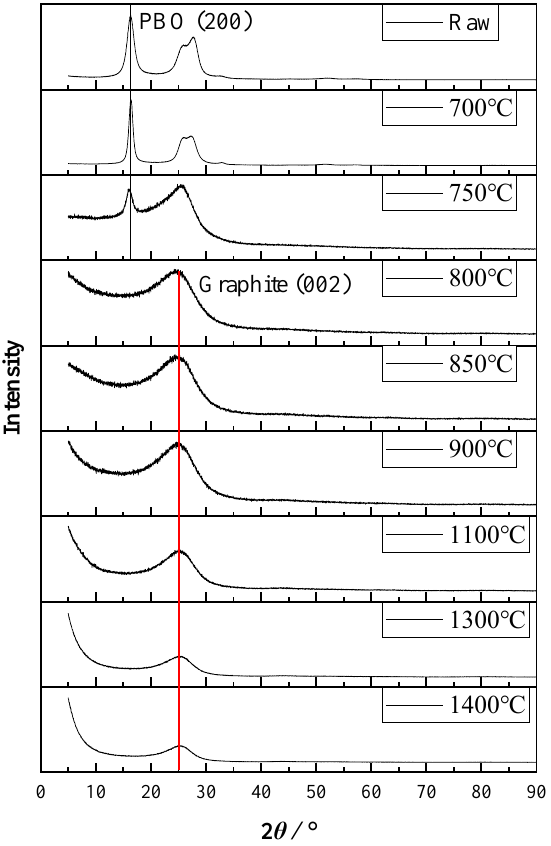
Figure 5. XRD pattern of each sample.